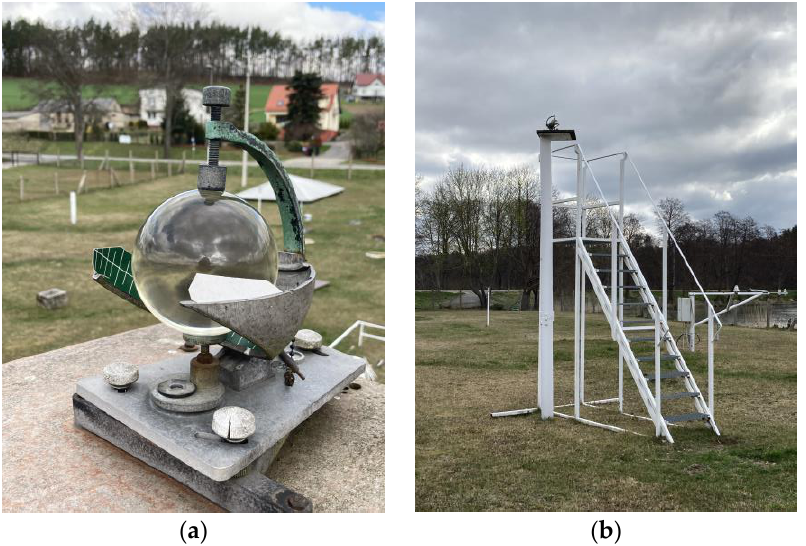
Figure 2. Campbell–Stokes sunshine recorder ( a ) and its tower ( b ) at the Borucino Limnological Station.